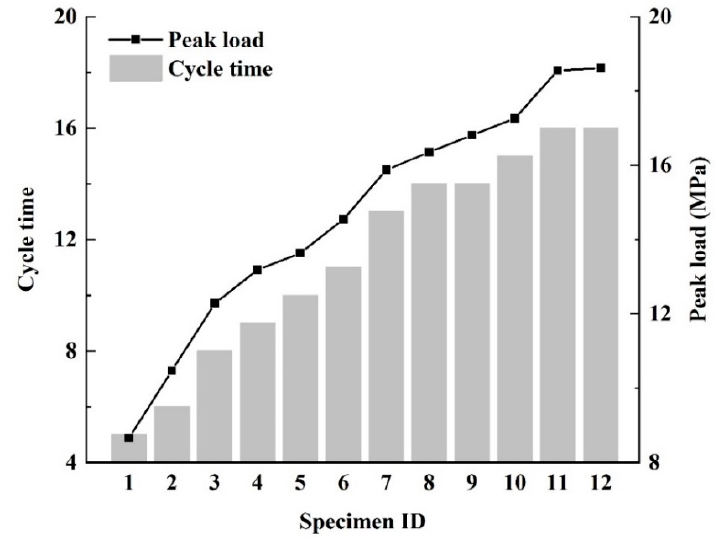
Figure 2. Cyclic loading path for each sandstone specimen.